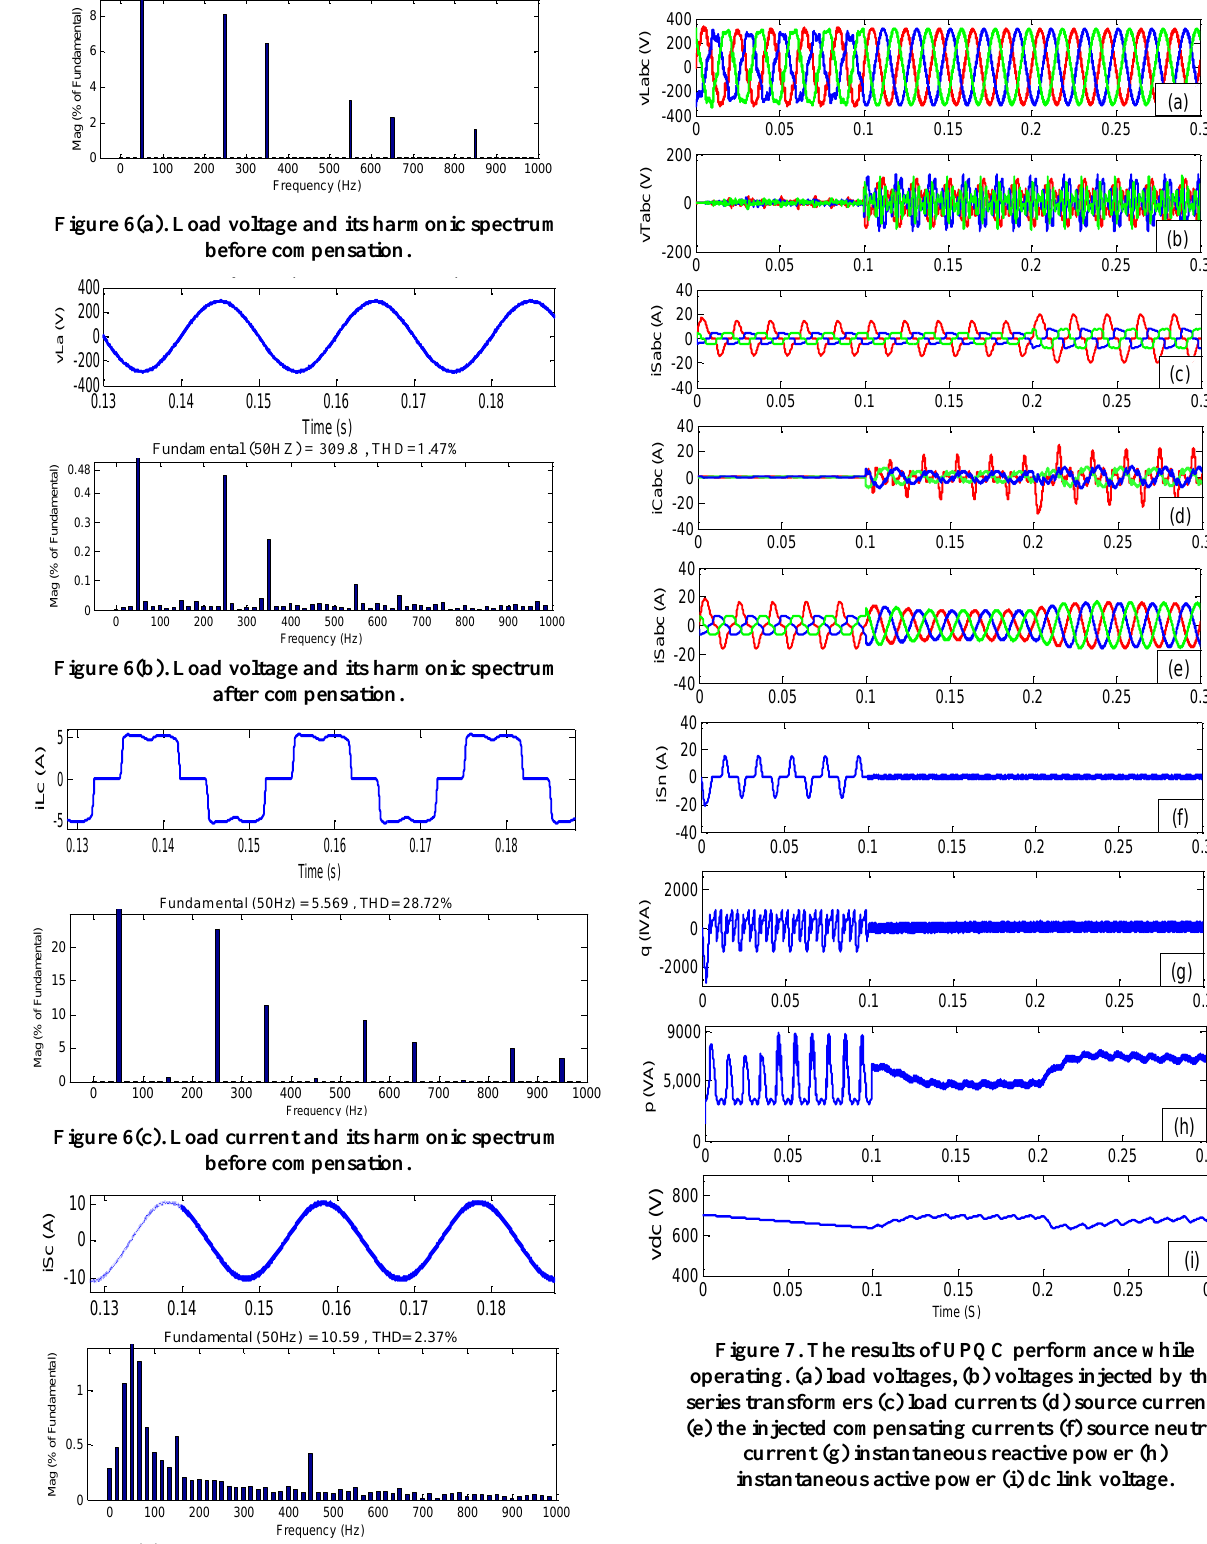
Figure 6(d). Load current and its harmonic spectrum after compensation.